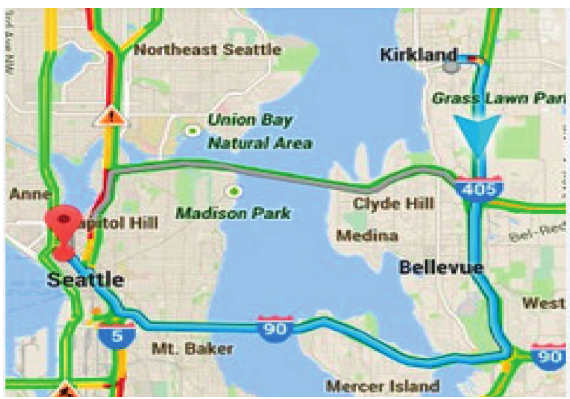
Figure 7: Driving route